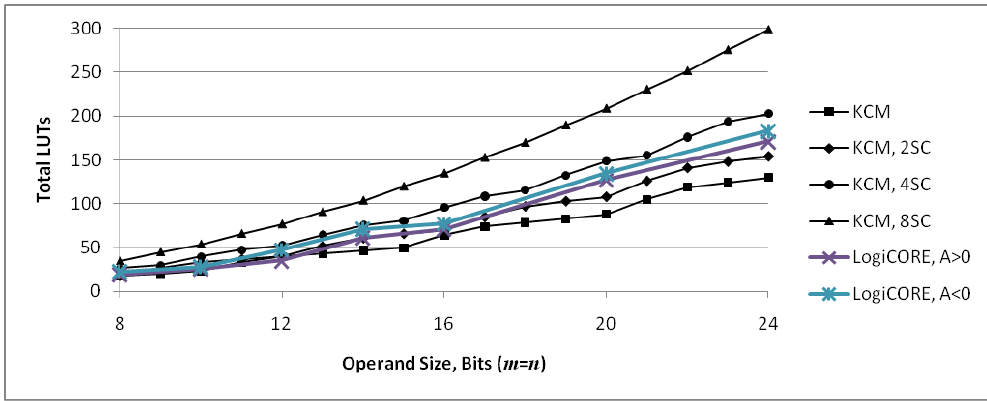
Figure 14. LUT6s required for KCMs, m = n . Values for proposed KCMs are computed maximums, and values for LogiCORE are from synthesized